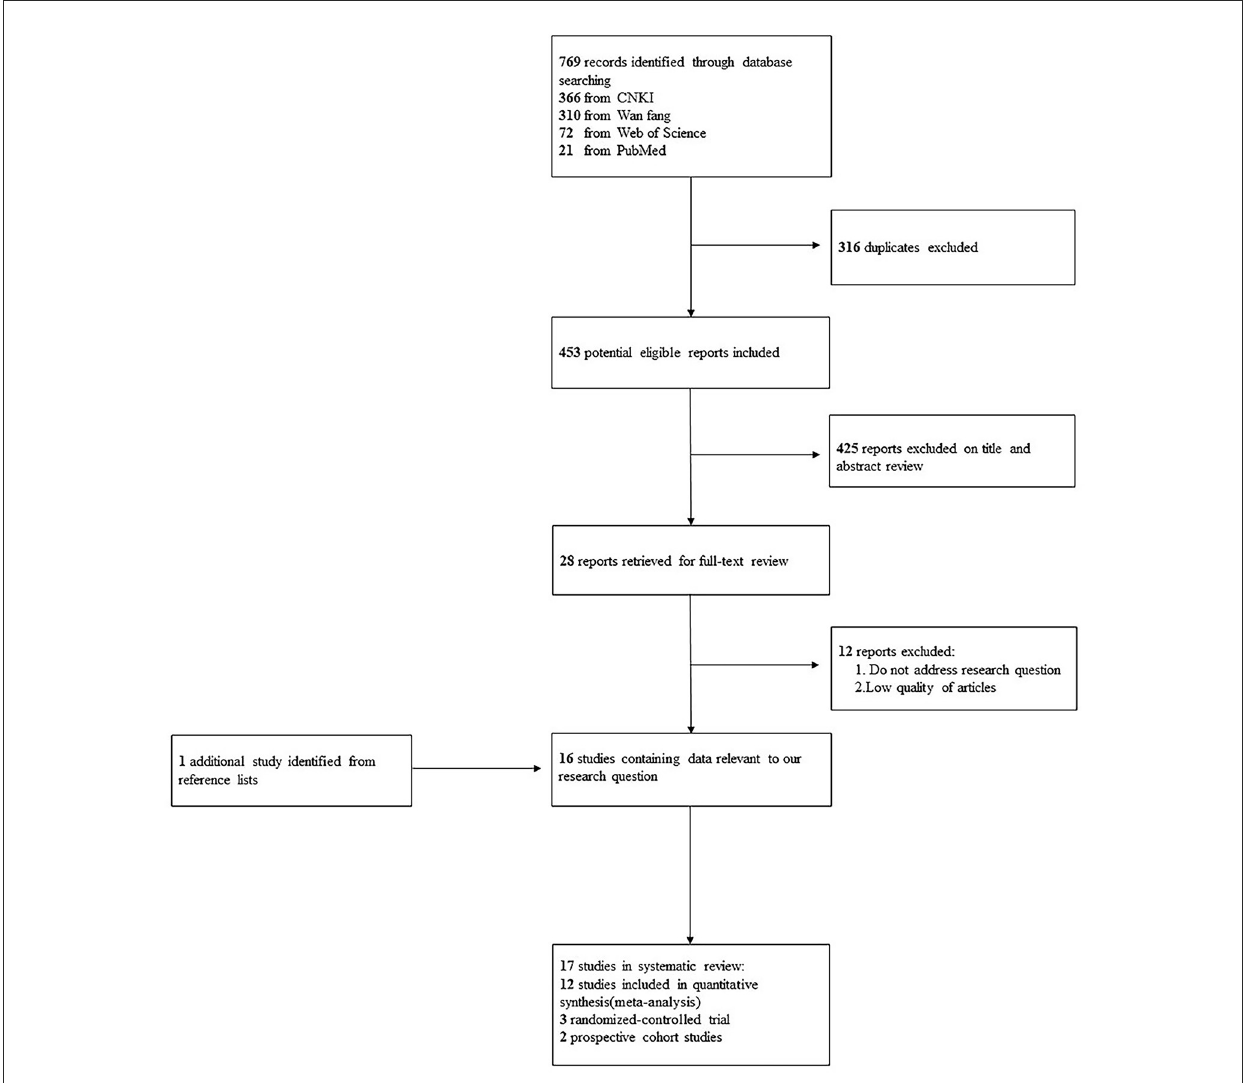
FIGURE1 Flow diagram outlining the selection process for the inclusion of studies in the systematic review and